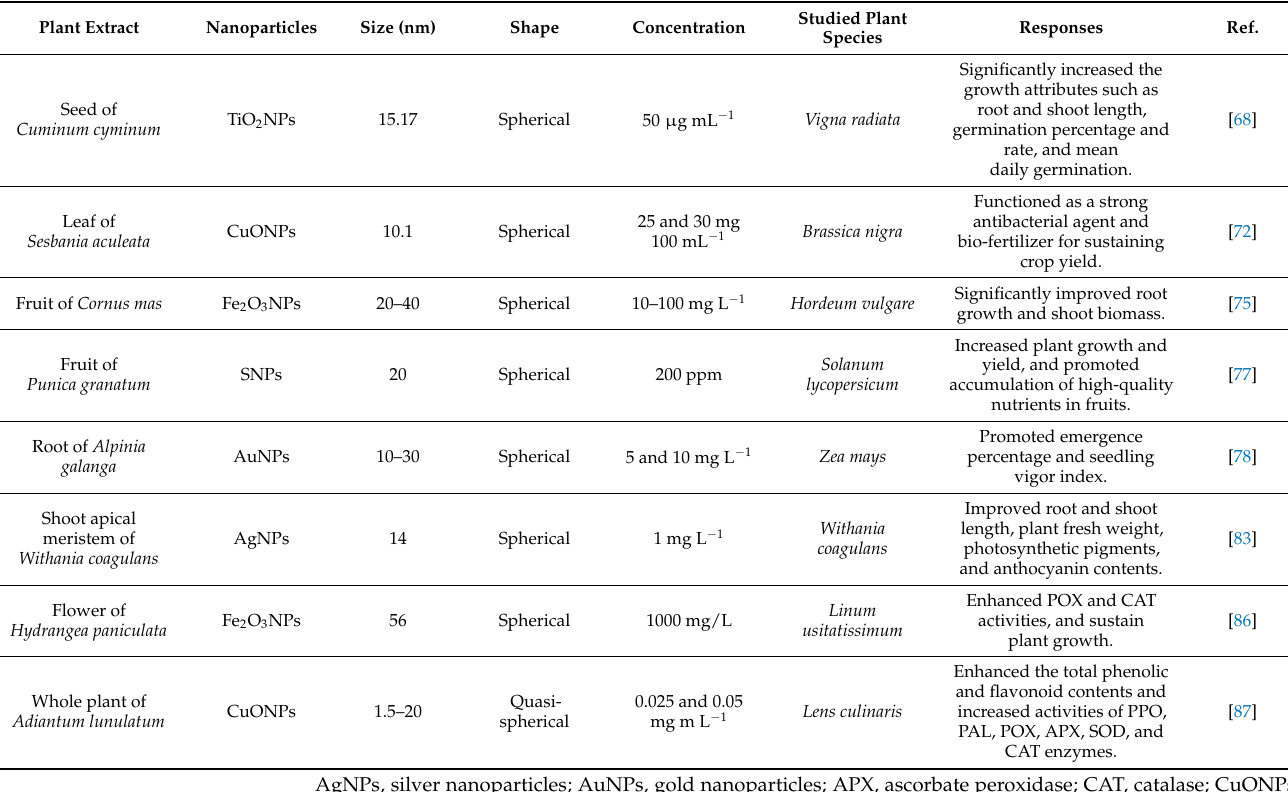
Table 2. Role of green synthesized nanoparticles in mediating reprogramming of plant traits.